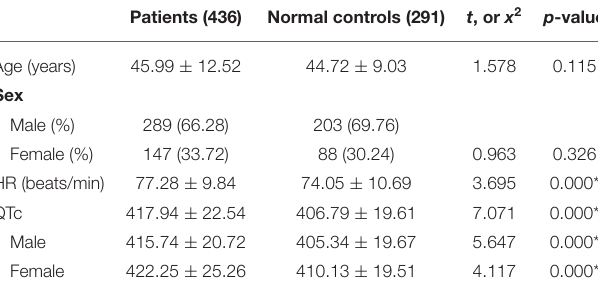
TABLE 1 | The demographics and ECG datas of schizophrenia patients and healthy controls. Patients